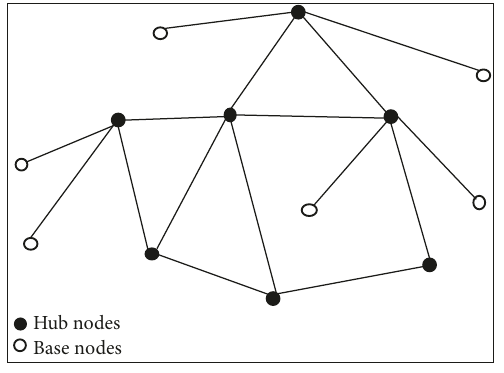
Figure 1: Mesh network